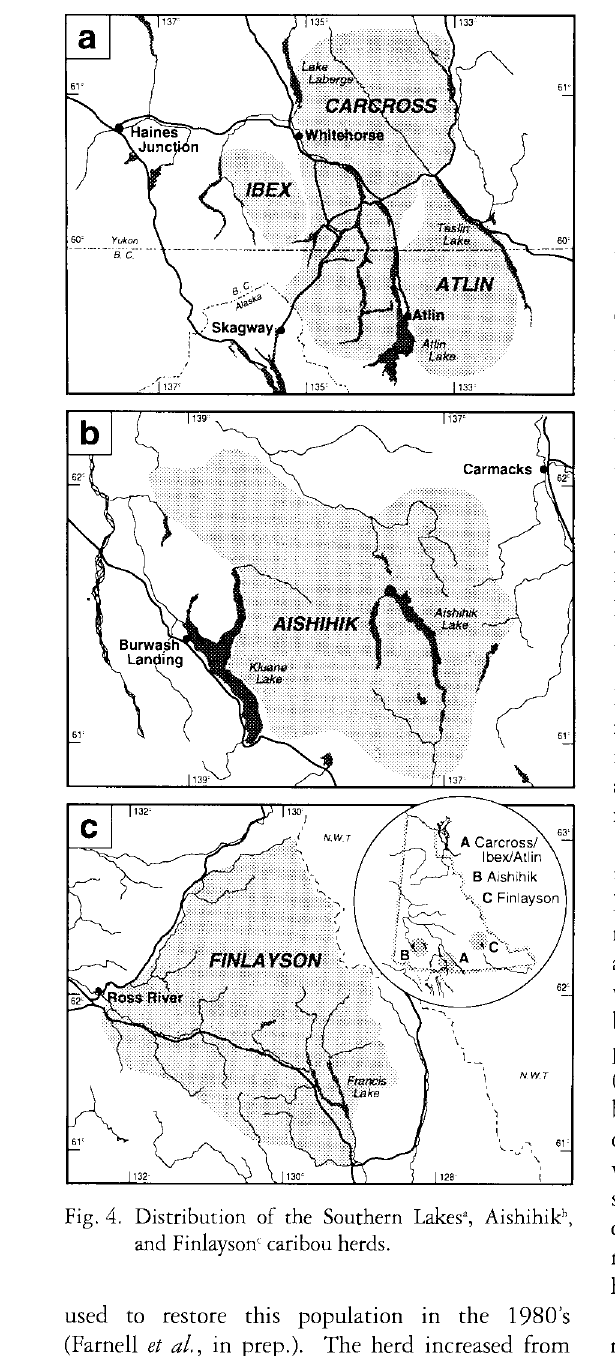
Fig. 4. Distribution of the Southern Lakes', Aishihik 1 ', and Finlayson' caribou